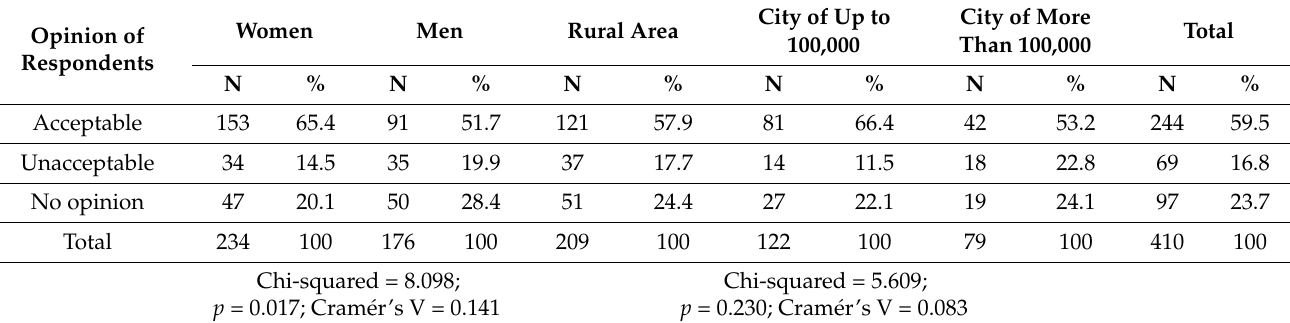
Table 6. Views on in vitro